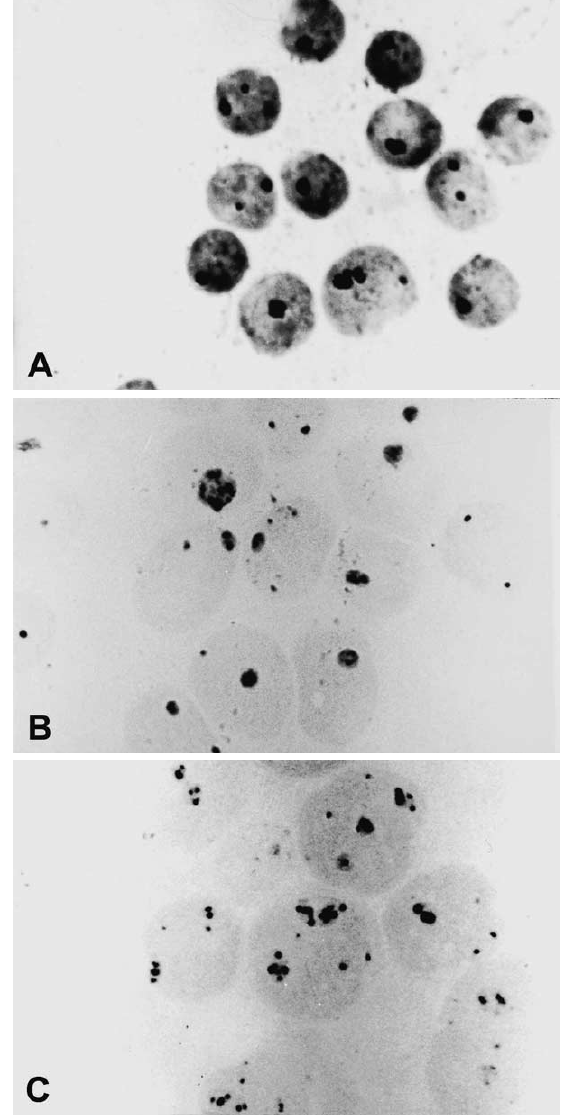
Fig. 1. Different AgNOR patterns in the cases: A – Follicular lym- phoma. Many of the cells present one compact nucleolus. One large cell presenting 2 clusters of AgNORs on the middle left. B – Mantle cell lymphoma. All cells exhibit one AgNOR cluster. C – B large cell lymphoma. All cells show AgNOR